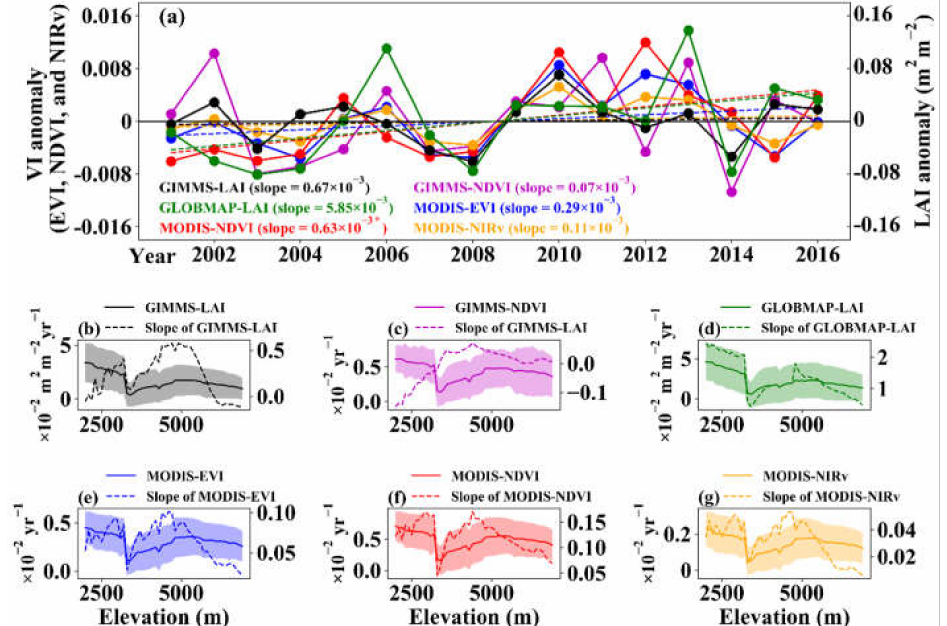
Figure 5. Trend of VIs ( a ) and their elevation distribution ( b – g ) in the QTP from 2001 to 2016. The dashed straight lines denote the trend lines in ( a ). The solid and dashed curves denote the mean value and slope of VI in ( b – g ). Asterisk (*) denotes that the slope is statistically significant at the 0.05 level. The colored shadow region represents one standard